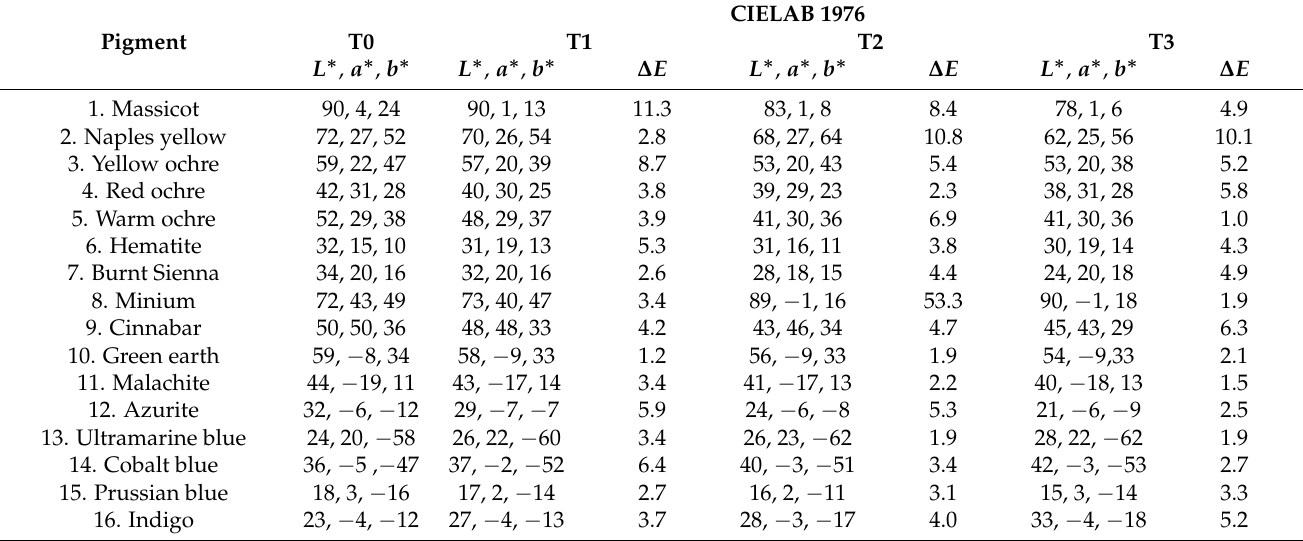
Table 4. L ∗ , a ∗ , and b ∗ values of CIELAB 1976 at different aging steps for the fundamental pigments of Section 1.1. ∆ E denotes the color difference compared to the previous aging